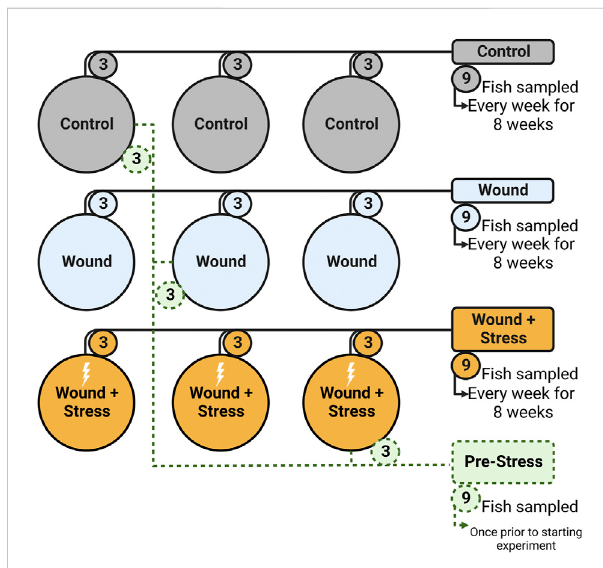
FIGURE 2 Experimental setup showing the nine tanks, three groups (Control, Wound, Wound + Stress), and the pre-Stress group. Numbers represent how many fi sh were taken from each tank on a sampling day (n =